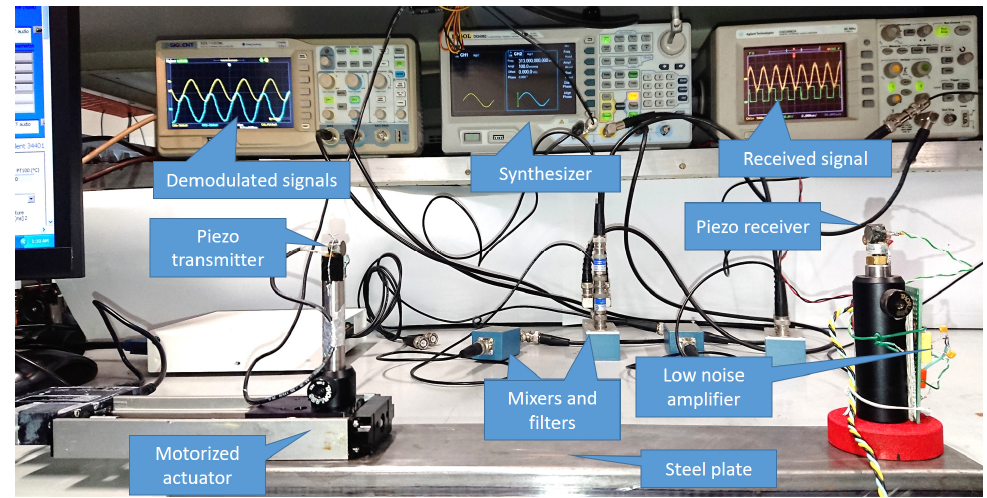
Figure 4. A picture of the CAT. In the foreground is the CAT unit mounted on the steel plate with the transmitter mounted on the translation stage ( left ) and the receiver fixed to the base ( right ). The amplifier board is mounted at the back of the holder of the receiver. On the table behind the CAT are the blue boxes with the mixers and the LP filters. The white box on the left is the connection to an A/D converter. On the bench are the synthesizer ( centre ) and the oscilloscope with the relevant signals: the RF amplified signal (yellow, right scope ) and the LF demodulated and filtered signals ( left scope ).